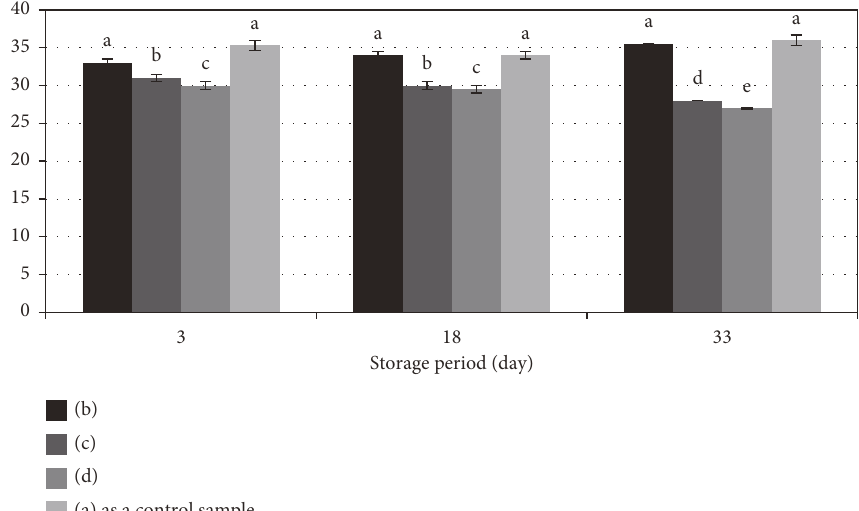
Figure 3: Changes in flavor score of Iranian UF cheese ∗ treated by KCl and NaCl during 33days of storage period. ∗ (a) 3% NaCl (control), (b) 1.50% NaCl+1.50% KCl, (c) 1.00% NaCl+2.00% KCl, and (d) 0.75% NaCl+2.25%